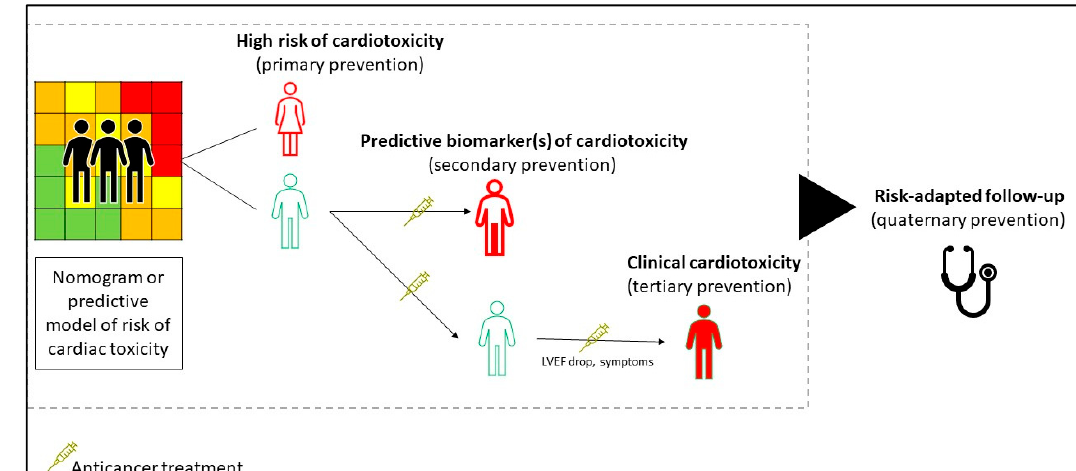
Figure 3. Proposed framework to identify the critical points for medical interventions to prevent and treat cardiotoxicity. The identification of cancer patients that are more susceptible to cardiac toxicity can prompt the development of interventions of primary prevention, which is adjusted for cancer types, previous treatments, and planned therapies. Validating prognostic and predictive biomarkers is critical for defining the benefits of early interventions, based on quality endpoints of cardiovascular mortality. The current strategy of the management of cardio-toxicity commonly takes the form of a tertiary type, treating patients with functional-structural alterations and cardiovascular symptoms. Eventually, the risk-adapted plans of follow-up can reduce the excessive medicalization and medical harms.